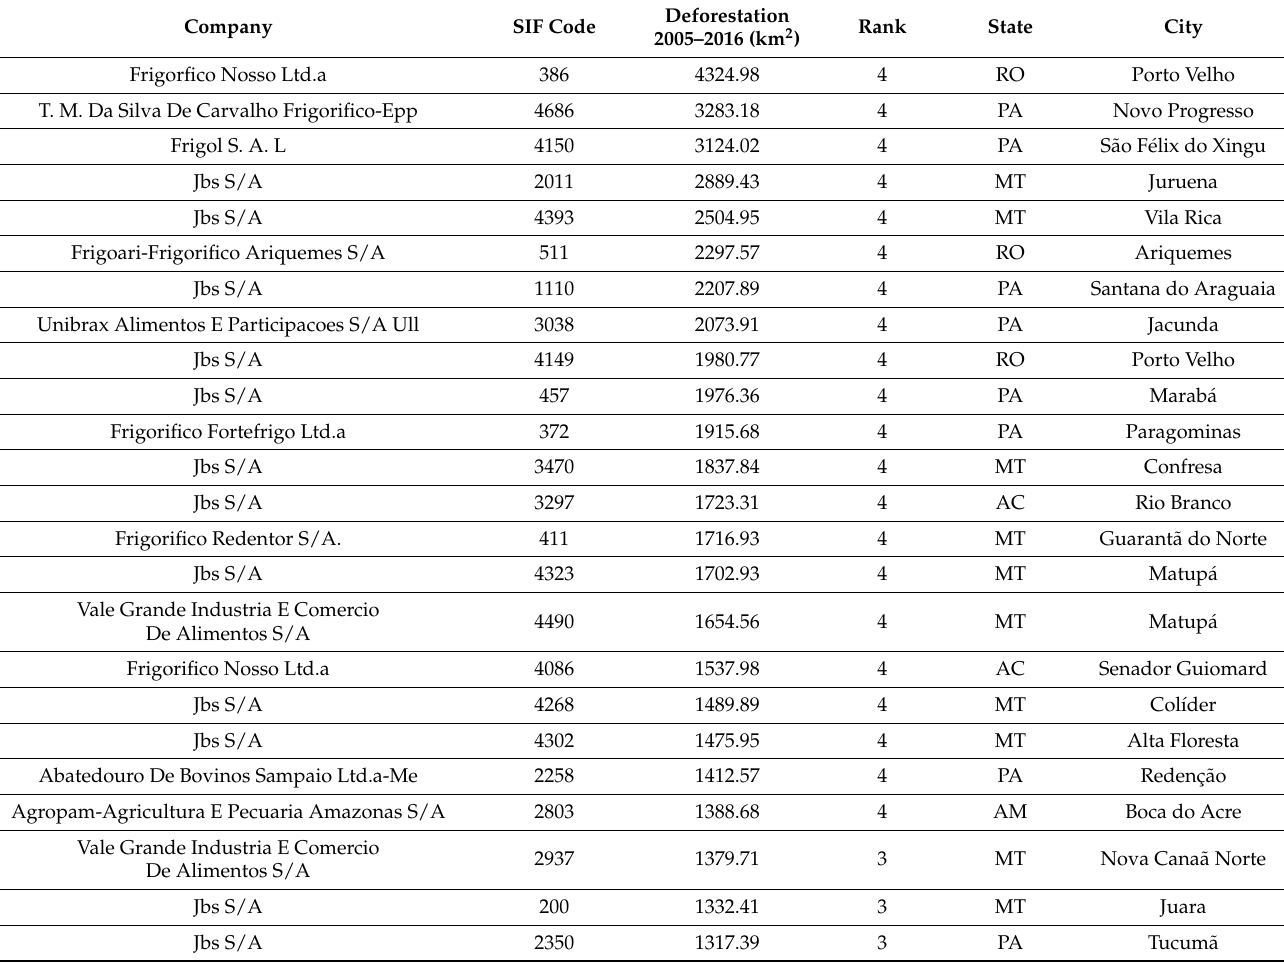
Table A1. List of slaughterhouses in Brazilian Legal Amazon, the assigned deforestation risk and associated information